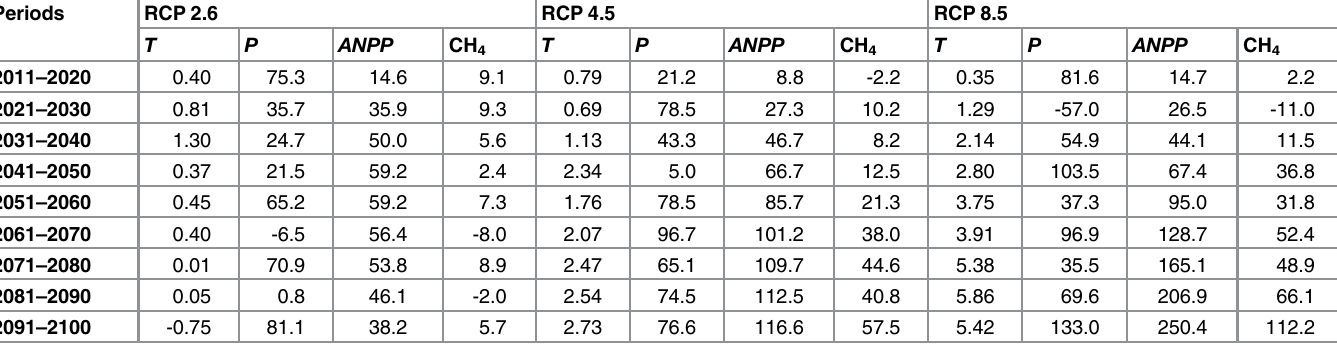
Table 3. Air temperature, precipitation, ANPP and CH 4 emissions compared with the average value of 2001 – 2010 under RCP scenarios over the Sanjiang Plain. Periods RCP 2.6 RCP 4.5 RCP